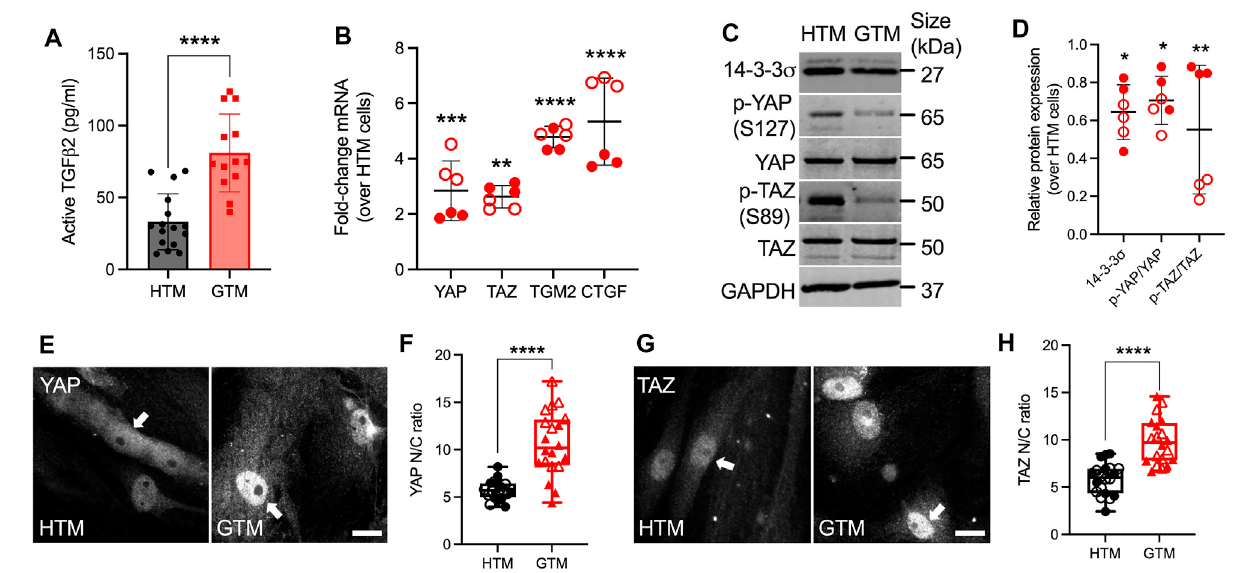
FIGURE 1 | Upregulated active TGF β 2 and YAP/TAZ nuclear localization in GTM cells compared to normal HTM cells. (A) Active TGF β 2 levels were quanti fi ed by ELISA ( n = 16 replicates from three HTM cell strains, n = 13 replicates from 2 GTM cell strains). (B) mRNA fold-change of YAP, TAZ, TGM2 and CTGF normalized to GAPDHbyqRT-PCR( n =6replicatesfrom2HTM/GTMcellstrains). (C) Immunoblot of14-3-3 σ ,p-YAP,p-TAZ,totalYAPandtotalTAZ. (D) Immunoblotanalysisof14- 3-3 σ , p-YAP/YAP and p-TAZ/TAZ normalized to GAPDH ( n = 6 replicates from 2 HTM/GTM cell strains). (E,G) Representative fl uorescence micrographs of YAP/ TAZ in HTM and GTM cells (YAP/TAZ = grey). Scale bar, 20 μ m; arrows indicate YAP/TAZ nuclear localization. (F,H) Analysis of YAP/TAZ nuclear/cytoplasmic ratio ( n = 20 images from 2 HTM/GTM cell strains with three replicates per cell strain). Open and closed symbols represent different cell strains. In (A,B,D) , the bars or lines and error bars indicate Mean ± SD; In (F,H) the box and whisker plots represent median values (horizontal bars), 25th to 75th percentiles (box edges) and minimum to maximumvalues(whiskers),withallpointsplotted.Signi fi cancewasdetermined byunpairedt-test (A,F,H) andtwo-way ANOVAusingmultiplecomparisonstests (B,D) (* p < 0.05; ** p < 0.01; *** p < 0.001; **** p <